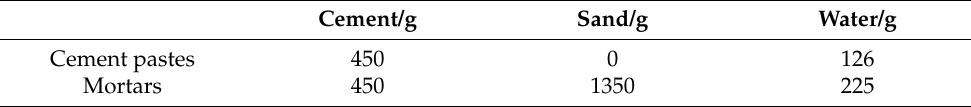
Table 2. The proportion of cement paste and mortars.